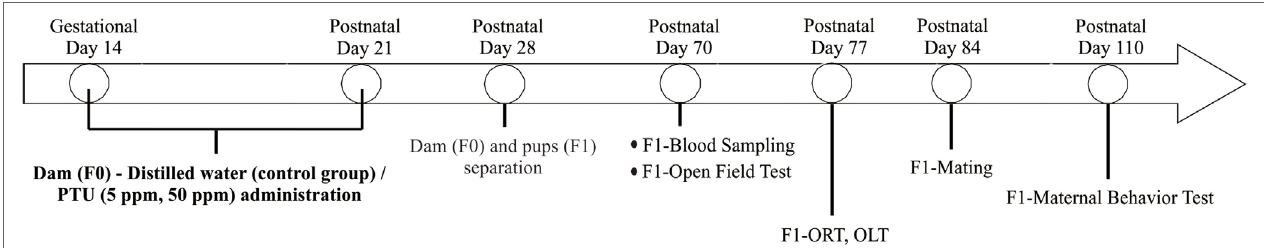
FigUre 1 | Schematic drawing of experimental procedure. Pregnant C57BL/6 mice received 5 ppm or 50 ppm propylthiouracil (PTU) from gestational day 14 to postnatal day 21. On postnatal day 28, we separated dams from pups. Some pups were sacrificed on postnatal day 70 for serum analysis, whereas others were kept for behavioral